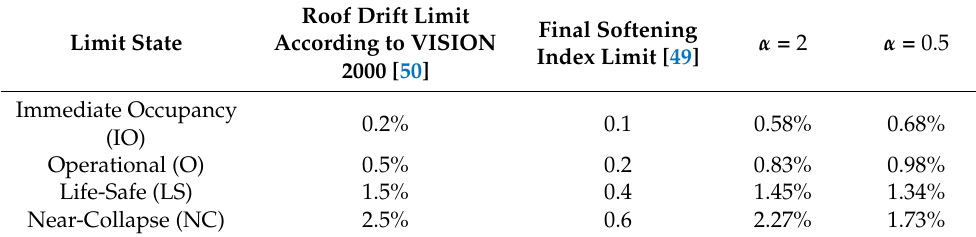
Table 6. Average roof drift values for each limit state in accordance with the triggered global failure mode.